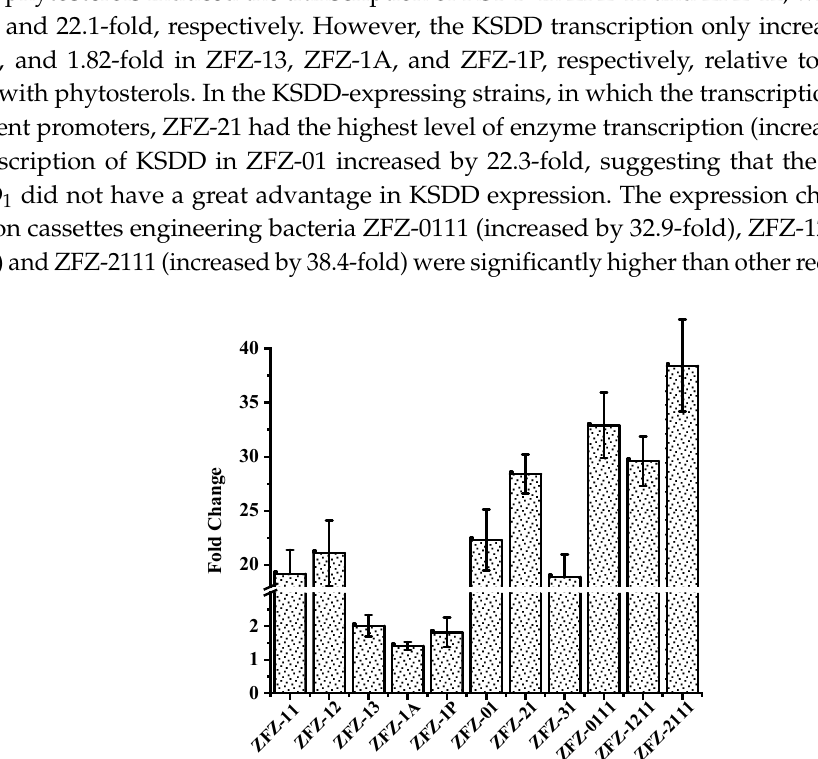
Figure 4. Analysis of KSDD genes transcription in recombinant strains. The fold change indicates the increase in expression level of recombinant strains after removing the level in Mycobacterium sp. ZFZ (ZFZ). The data were calculated from three independent experiments.